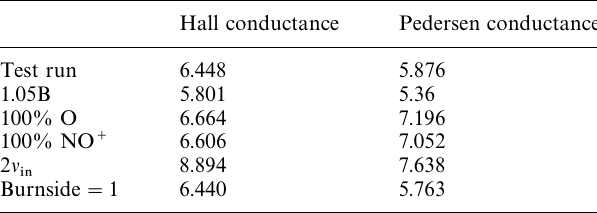
Table 1. Numerical influence of several parameters on a given ‘‘representative’’